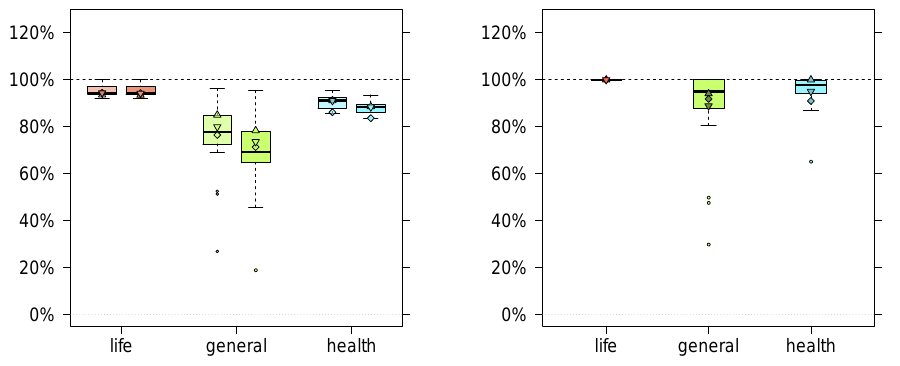
Figure 12. (lhs) illustrates the impact ratios (cid:36) i for longevity risk and a reserve strengthening (left plots) as well as together with a cascading decline new business (right plots); (rhs) illustrates the impact ratios (cid:36) i resulting from a terrorist